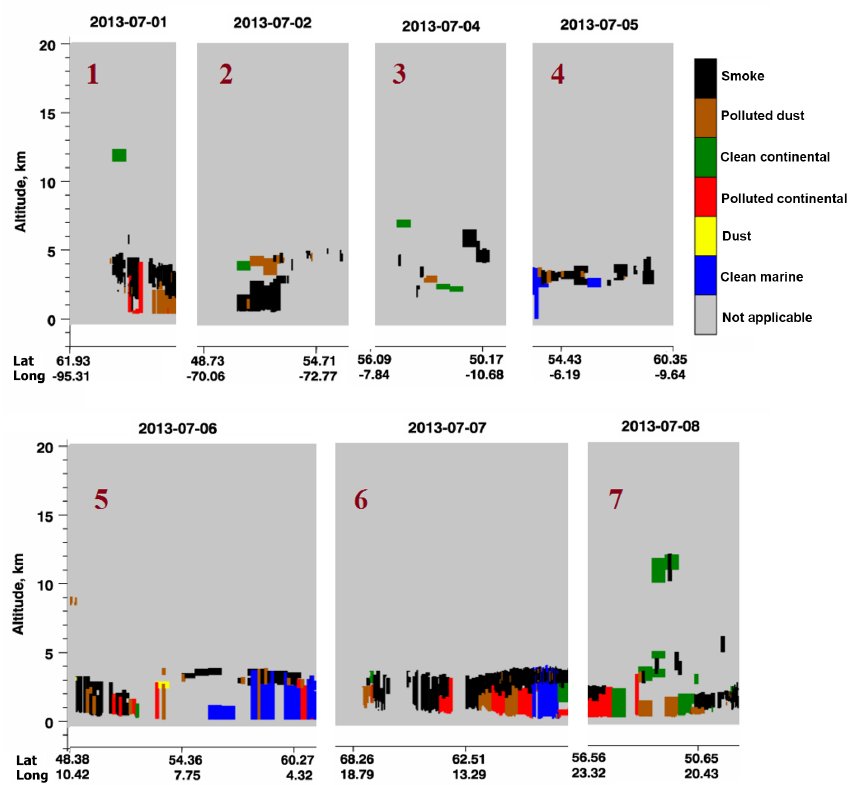
Figure 6. Position (altitude, latitude and longitude) and type of the aerosol layers detected by CALIPSO for each of the overpasses tracking the masses arriving at Warsaw (depicted in Fig. 5 as 1–7), with black color indicating smoke aerosol particles. Table 2. Average particle optical properties for the selected thin layers within the smoke zone.